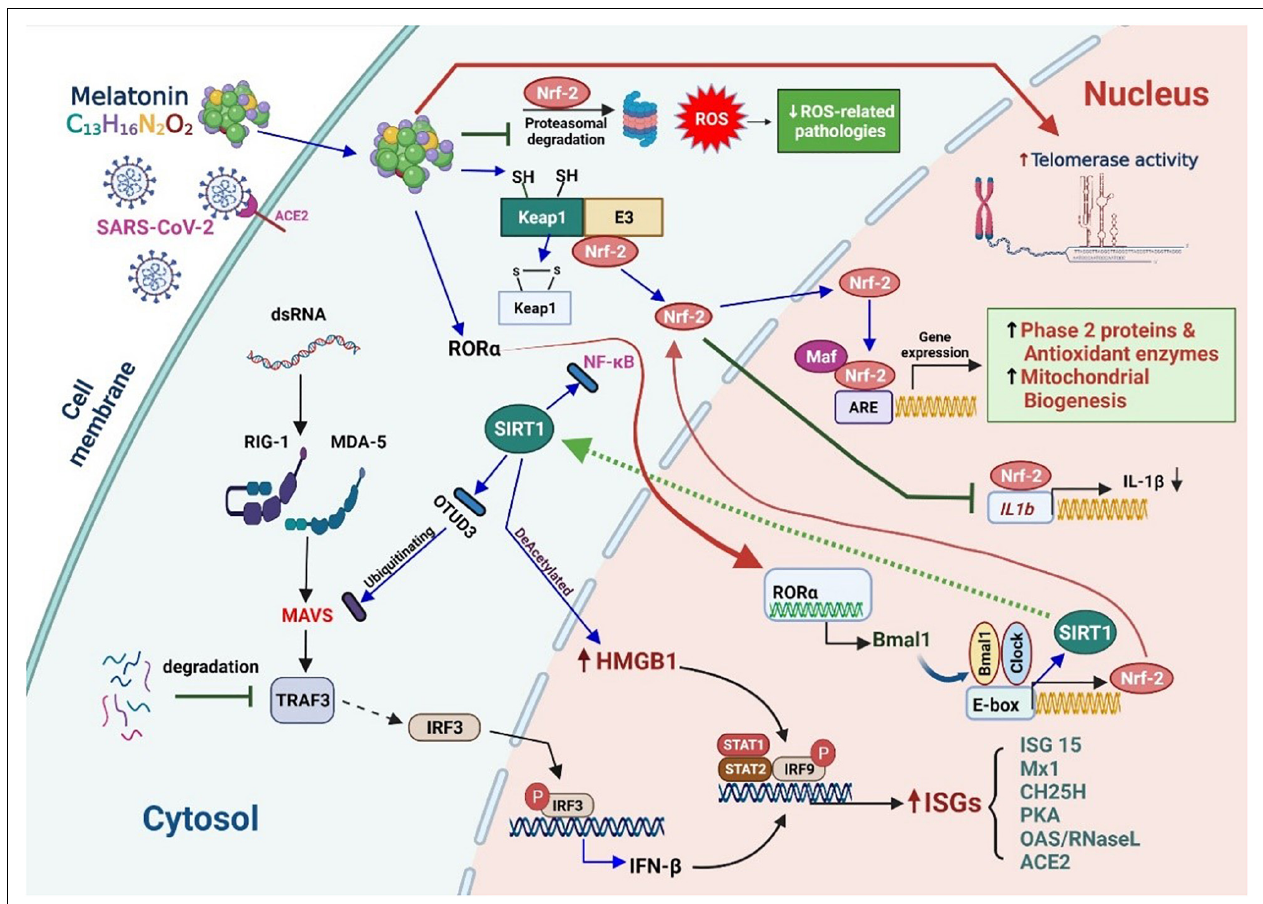
FIGURE 7 | Melatonin supplementation reduces the risk of coronavirus disease (COVID-19) by rescuing the repression IFN/ISG production. Melatonin supplementation restores the suppressed production of IFN/ISG, increases telomerase activity, upregulates SIRT1 expression, enhances virus-mediated MAVS activation, promotes nuclear translocation of the transcription factor ROR α , enhances Bmal1 expression, and further upregulates SIRT1 and Nrf2 expression to reduce the risk of COVID-19. Cellular responses to RNA viruses tend to activate IRF3, NF- κ B, ATF2, and c-Jun, which may bind to the promoter of the IFNB1 gene and promote its transcription. Overall, melatonin can help suppress processes that promote inflammation, such as NO production, cyclooxygenase 2 activity, NLRP3 inflammasome formation, and cytokine release, in elderly patients with COVID-19. It also activates processes in the anti-inflammatory network, including SIRT1 activation, Nrf2 upregulation, NF- κ B downregulation, and release of the anti-inflammatory cytokines IL-4 and